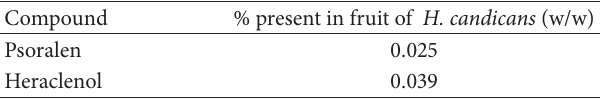
Table 2: Percent of psoralen and heraclenol in H. candicans fruits. Compound % present in fruit of H. candicans (w/w) Psoralen